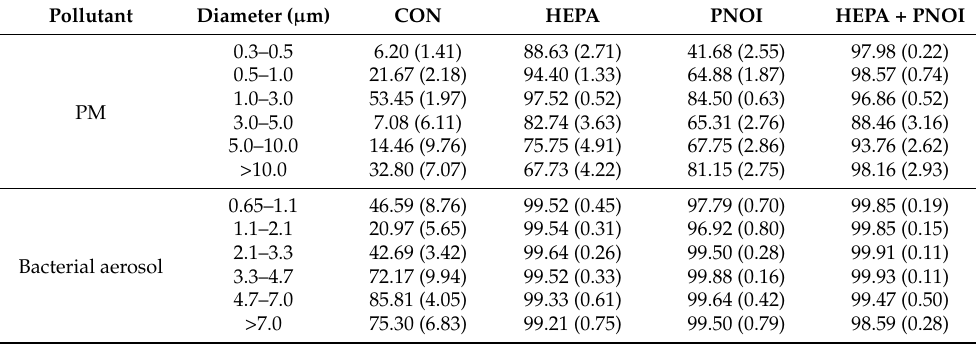
Table 2. Six particle sizes of particles and aerosol purification rate (%, mean (SD)).